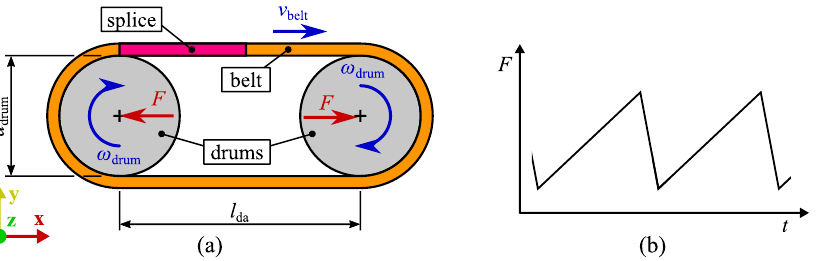
Figure 1. Belt test rig to determine the cyclic strength of a belt splice following [1]: ( a ) Setup of the test rig and ( b ) applied load